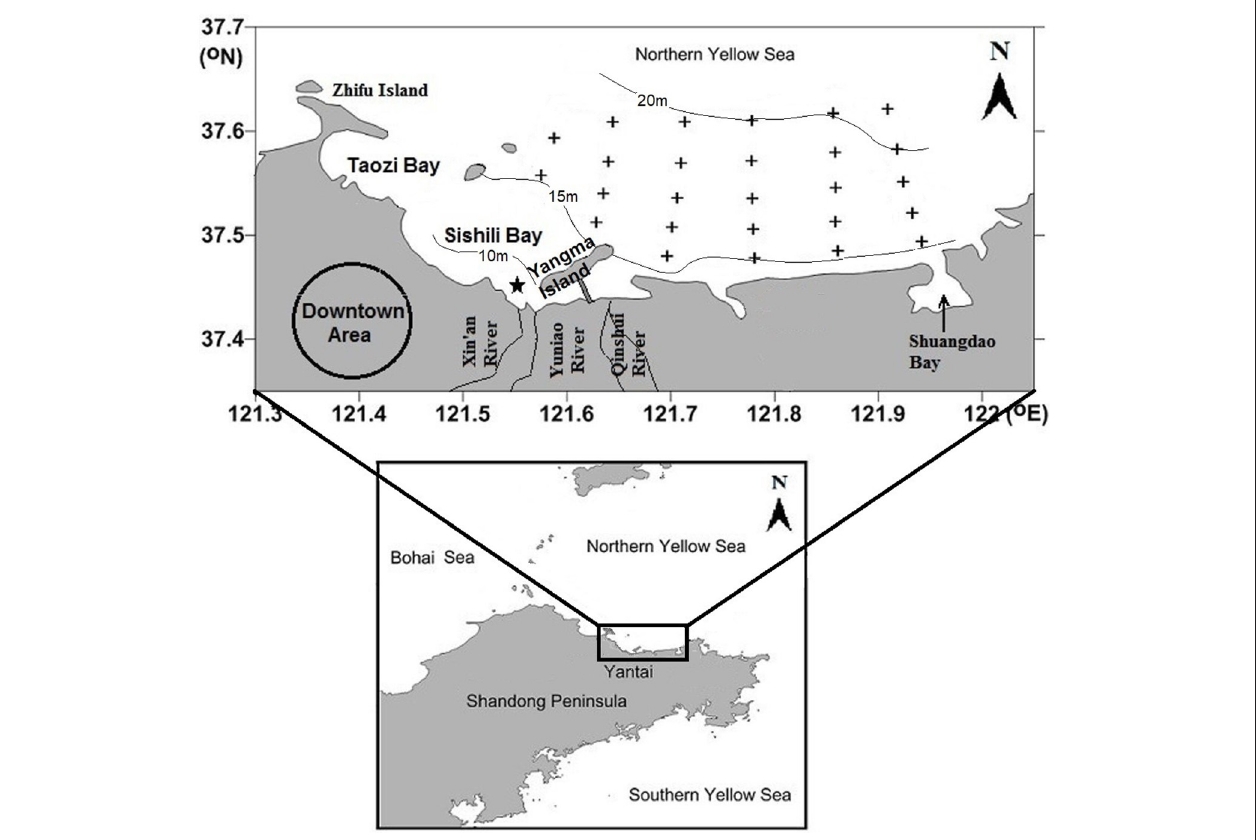
FIGURE 1 | Sampling sites (indicated by black crosses) in the mariculture area off Yantai city, China. The 10, 15, and 20m depth contours are indicated by solid lines. The sewage outlet of Xin’an Sewage Treatment Plant is indicated by a black